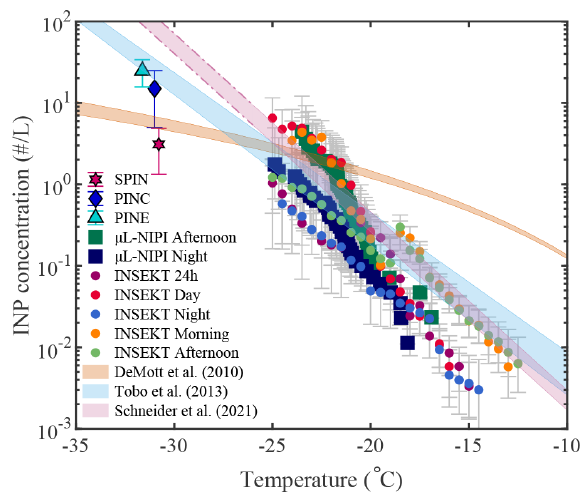
Figure 11. INP temperature spectra from all the instruments run- ning on 28 March. Error bars assigned to online measurement tech- niques represent the standard deviation of the processed data shown in Fig. 8. The DeMott et al. (2010), Tobo et al. (2013) and Schnei- der et al. (2021) parameterizations are replotted with the envelopes now indicative of the average N p ( > 0 . 5µm) ± 1 standard deviation for DeMott et al. (2010) and Tobo et al. (2013), as well as the av- erage air temperature T air ± 1 standard deviation for the Schneider